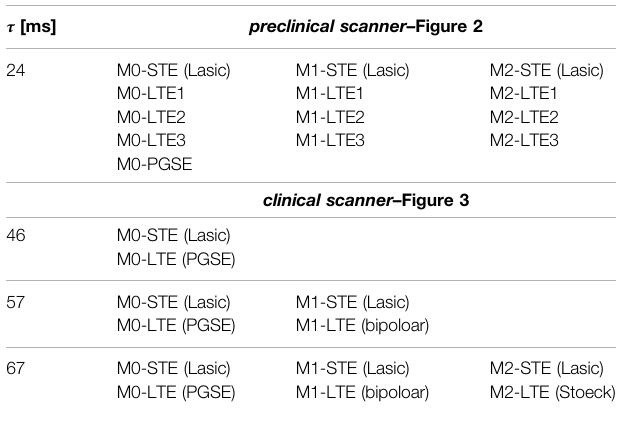
TABLE 1 | Summary of all diffusion encodings at different encoding times τ , degrees of motion compensation (M0, M1, M2) and b-tensor shapes (STE, LTE) on preclinical ( Figure 2 ) and clinical ( Figure 3 ) scanners. For each degree of motion compensation, the preclinical LTE1/LTE3 waveforms yield similar/different MD compared to the STE waveforms (see Figure 2 ).